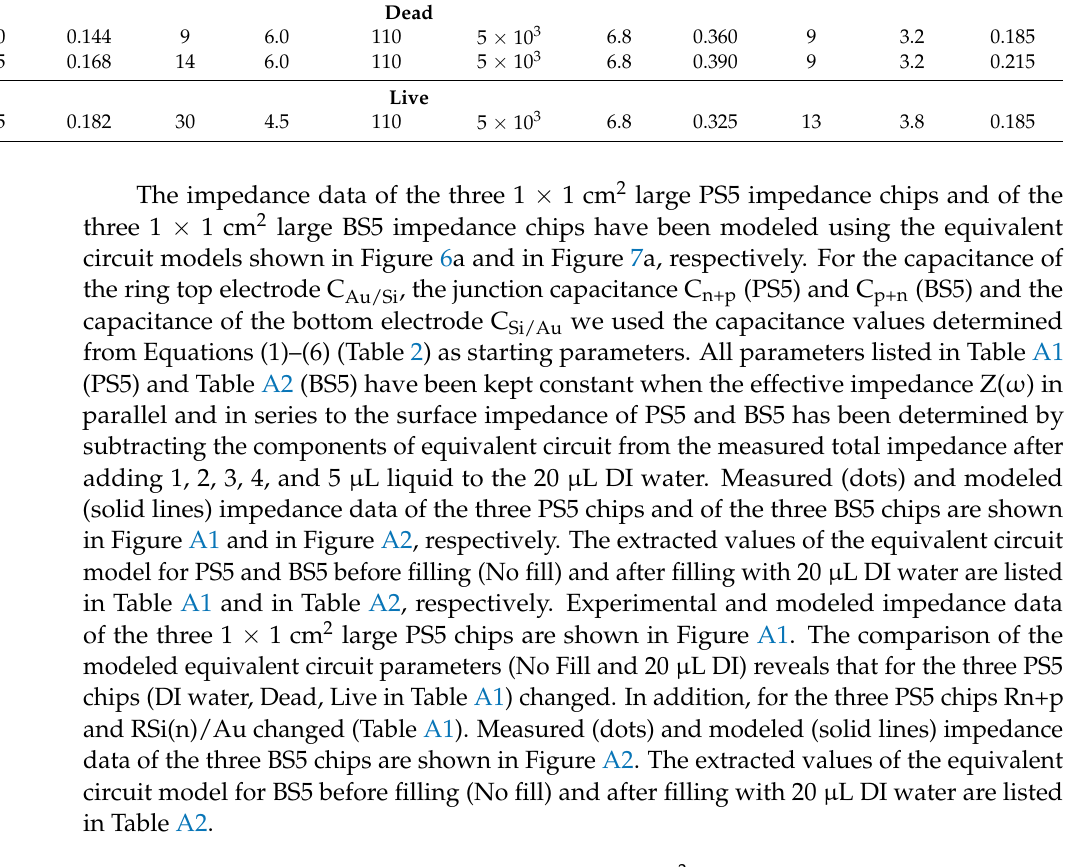
in Table A2. Table A2. Modeled parameters of the equivalent circuit (Figure 7a) of the three 1 × 1 cm 2 large BS5 impedance chips used for the investigation of adding 1, 2, 3, 4, and 5 µ L liquid with DI Water, with dead cells and with live cells before filling (No Fill) and after filling with 20 µ L DI water. Top Contact (Surface Impedance) p + n Junction Bottom Contact PS5 C Au/liq ( µ